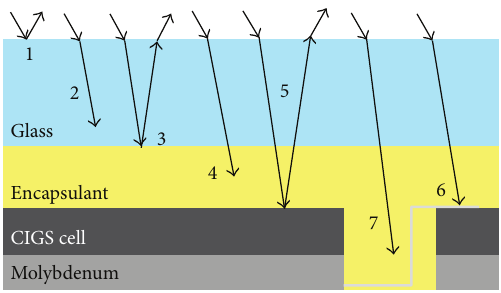
Figure 6: Cross-sectional diagram of a conventional photovoltaic module (not in scale), and the optical loss as described in the text.